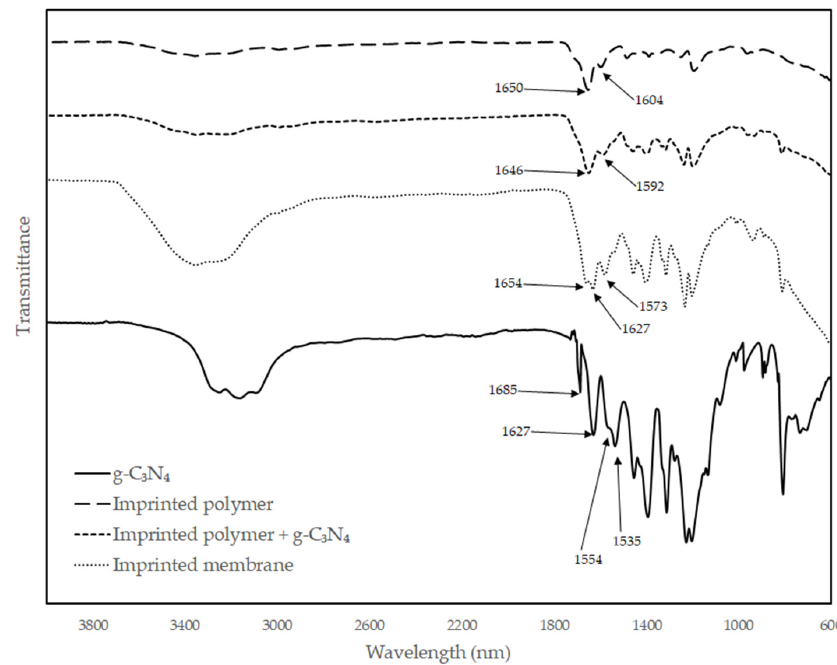
Figure 3. FT-IR for g-C 3 N 4 , imprinted adsorbents and membranes for arsenate removal.